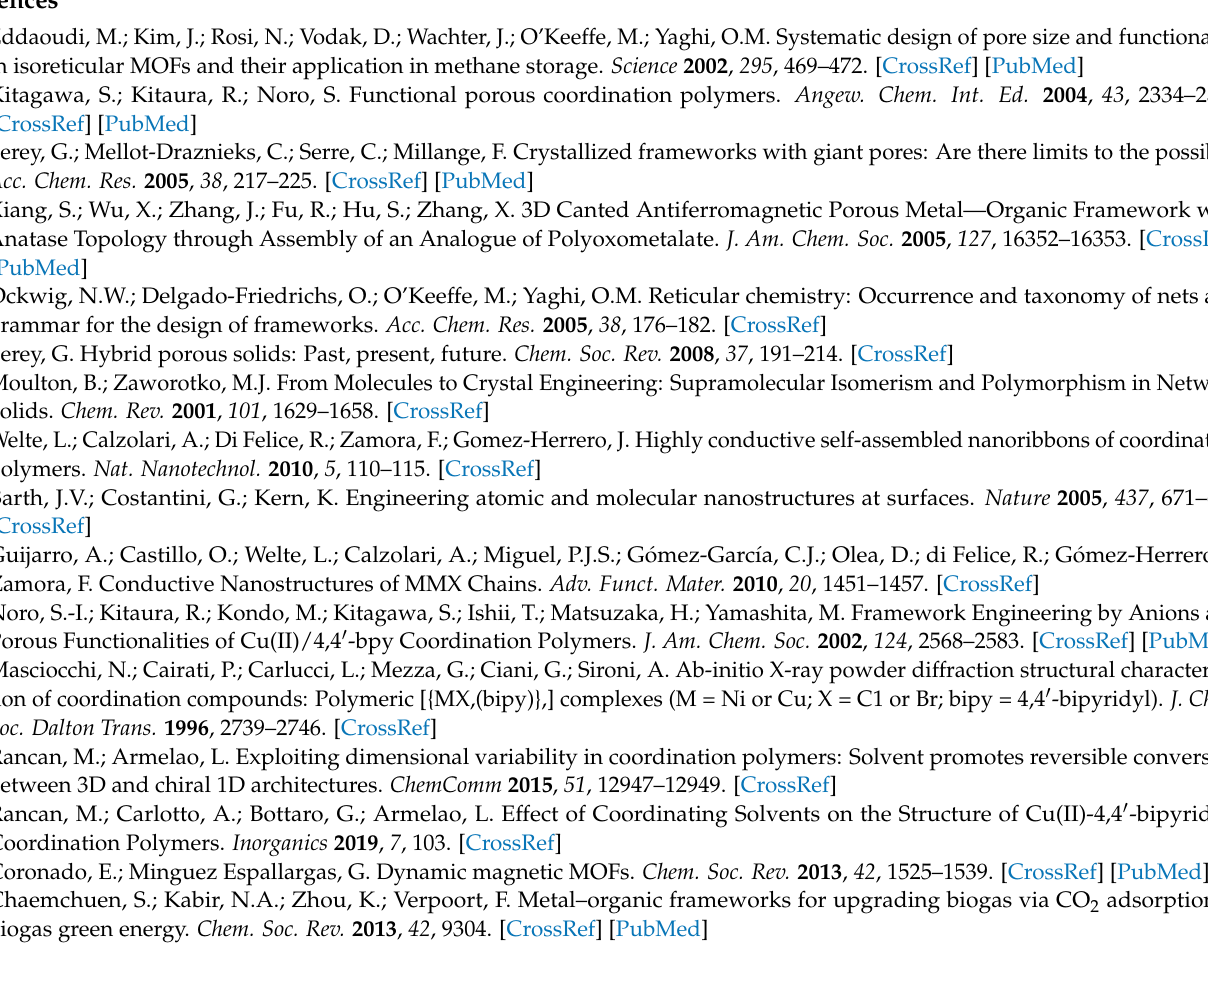
Figure S3: Plot of χ M ( ) vs. T for a powdered sample of compound 1 , Figure S3: Plot of χ M − 1 ( vs. T of compound 1 . The solid line represents the best fit χ M − 1 above 500 K with a Curie-Weiss law, (cid:35) Figure S4: Plot of χ M ( ) vs. T of compound 1 , Figure S5: Magnetic exchange coupling scheme of [Ni 3 ( µ 3 -CrO 4 )]-based layer of compound 1 , Figure S6: ZFC/FC magnetizations of compound 1 at the (cid:35) field of 10 Oe, Figure S7: In phase ( χ (cid:48) ) and out-off phase ( χ (cid:48)(cid:48) ) of the AC magnetic susceptibilities in a zero applied DC field and a 3.5 G AC field at the indicated frequencies for compound 1 , Figure S8: A blow-up of the hysteresis loop of compound 1 at the 1.8 K, Figure S9: d M /d H vs. H plots for the virgin magnetization of compound 1